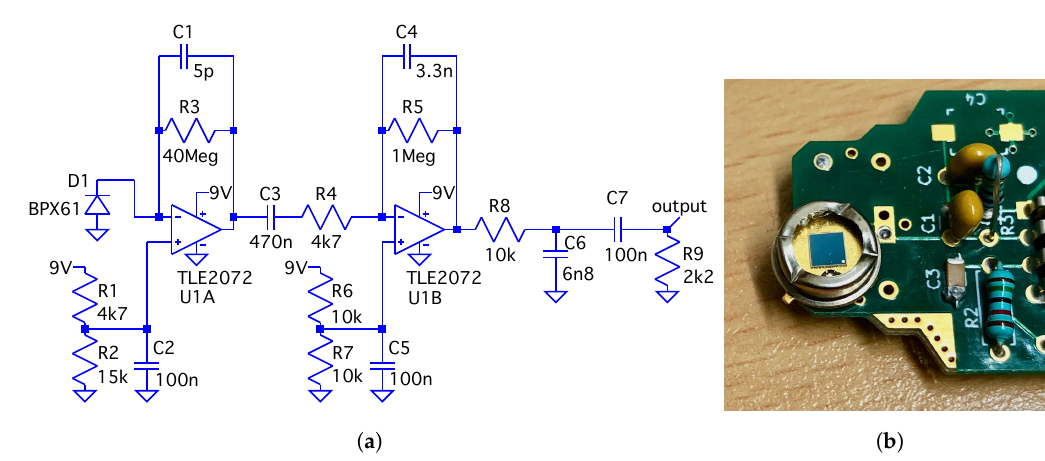
Figure 2. PIN diode and its amplifier circuit: ( a ) A dual-stage amplification circuit optimised for full waveform sampling at low audio sampling rates. ( b ) The surface of the silicon diode chip is exposed to radiation directly by removing the glass cover of the metal can package. The glass was broken off by carefully applying pressure using a wire cutter at four positions around the metal case.